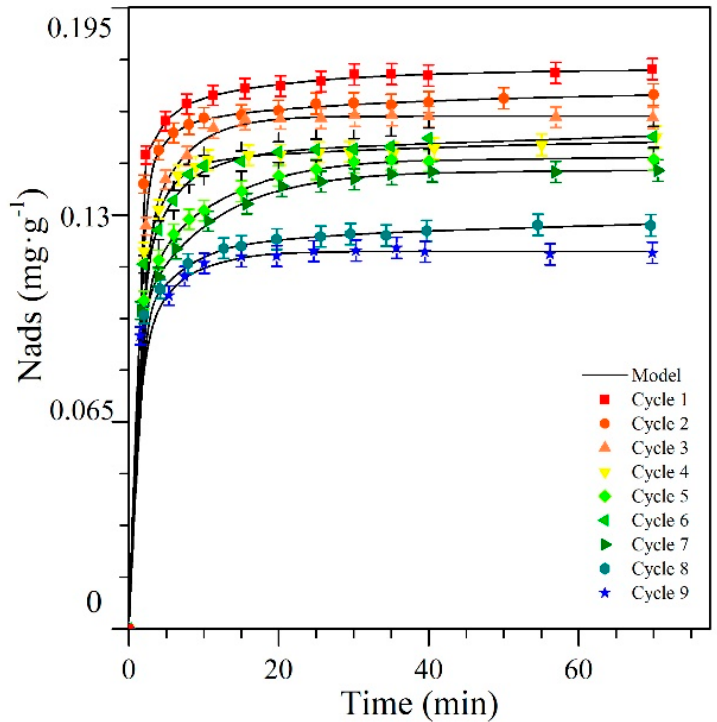
Figure 1. Asphaltene adsorption kinetics on CeNi0.89Pd1.1 nanoparticles through several catalytic regeneration cycles of adsorption and subsequent catalytic steam gasification. Adsorption kinetics were constructed for a fixed initial concentration of n -C 7 asphaltene of 10 mg · L − 1 . The symbols are experimental data, and the continuous lines are from the double exponential model.